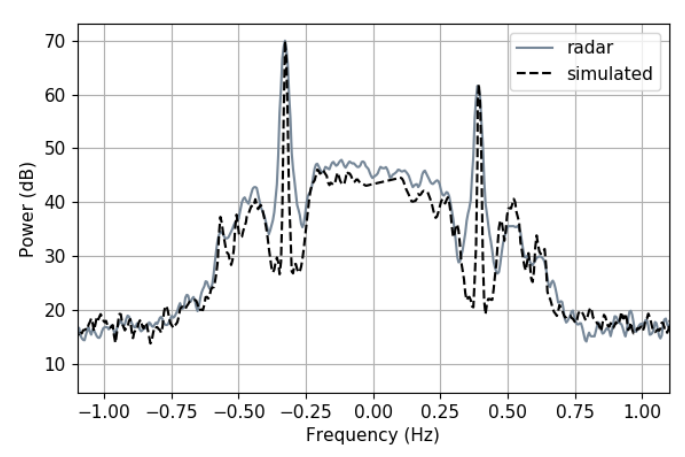
Figure 2. Comparison of measured and simulated monostatic Doppler spectra. The simulated Doppler spectrum has been generated using wave buoy data, measured at the same time and place as the radar Doppler spectrum. Radar and buoy data provided by Daniel Conley, Univeresity of Plymouth